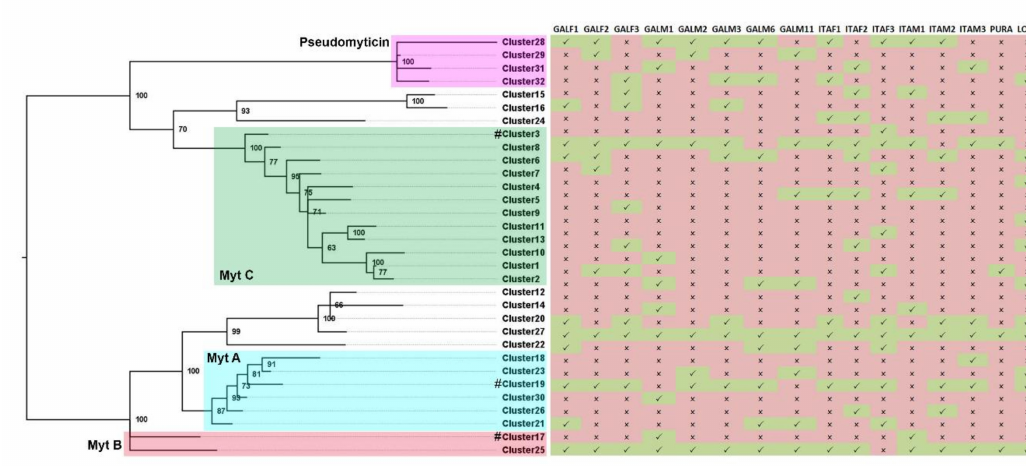
Figure 3. Presence / absence evaluation of the 32 clusters of myticin. The matrix shows presence / absence of each cluster in the 16 mussel genomes. Green (MytC), red (MytB), blue (MytA), and purple (pseudomyticin) squares show the position of the four main described groups of myticins and pseudomyticins. # represents previously published Myt A / B / C